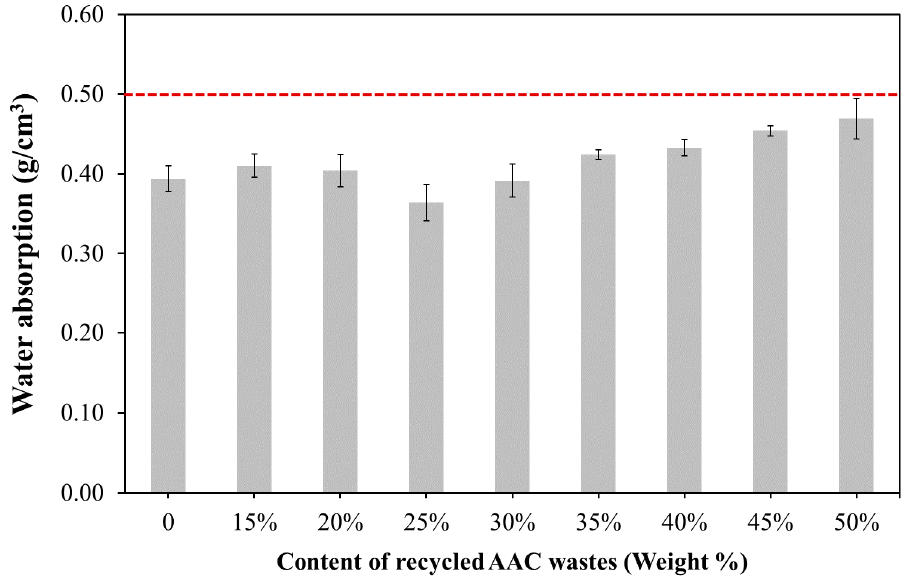
Figure 7. AAC water absorption ratios with varied concentrations of fine recycled powder (the red dash line indicates the maximum acceptable value of water absorption according to the ASTM C1692-18 standard).